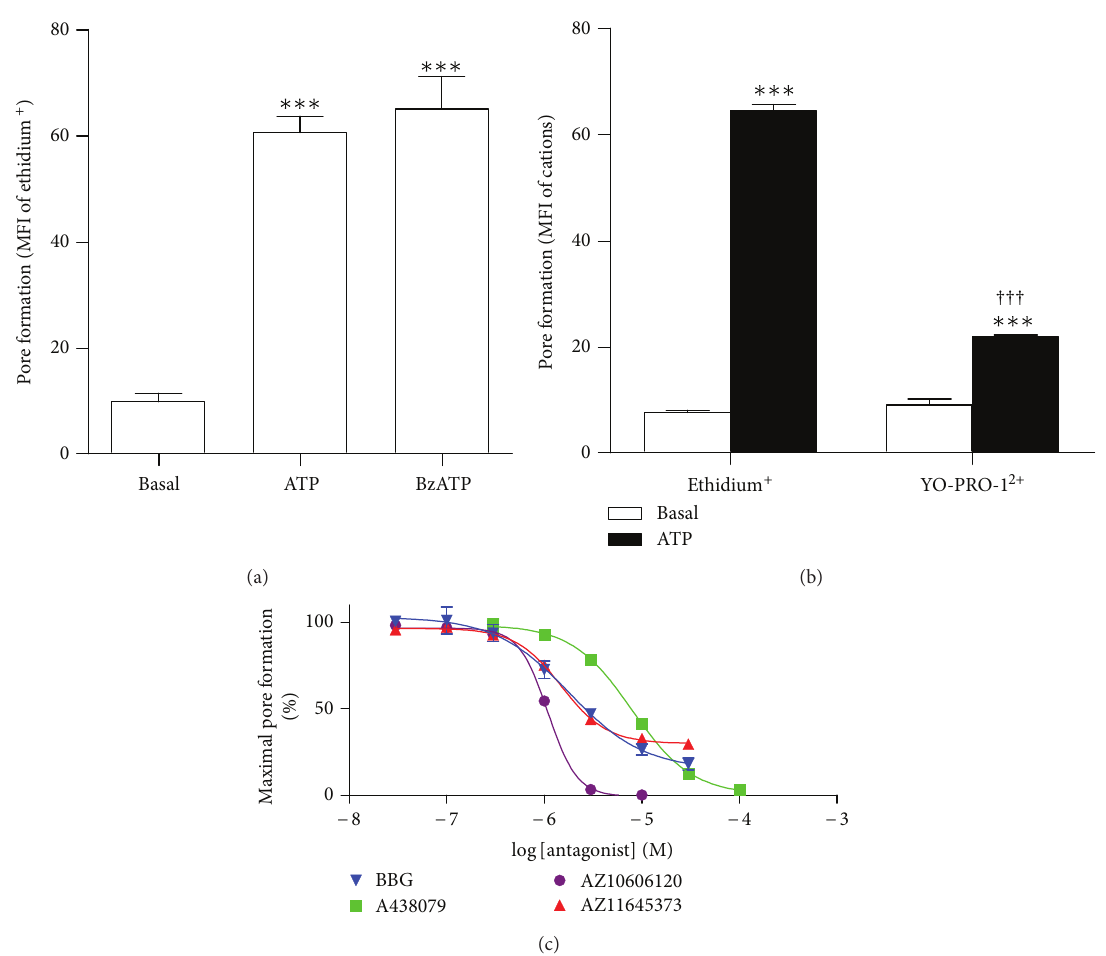
F 1: P2X7 antagonists inhibit ATP-induced ethidium b) J774 cells in NaCl medium were incubated with (a and b)